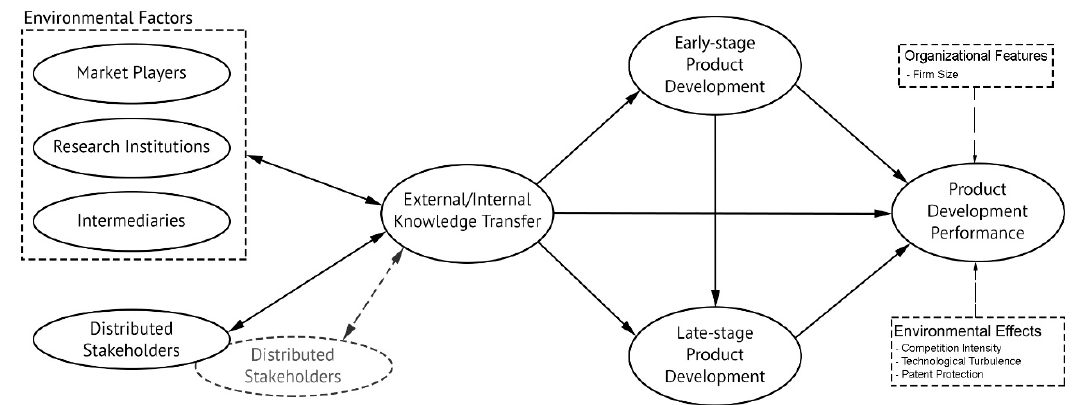
Figure 3. Revised multi-mediation framework for the effect of functional involvement in distributed collaborative product development for future studies.